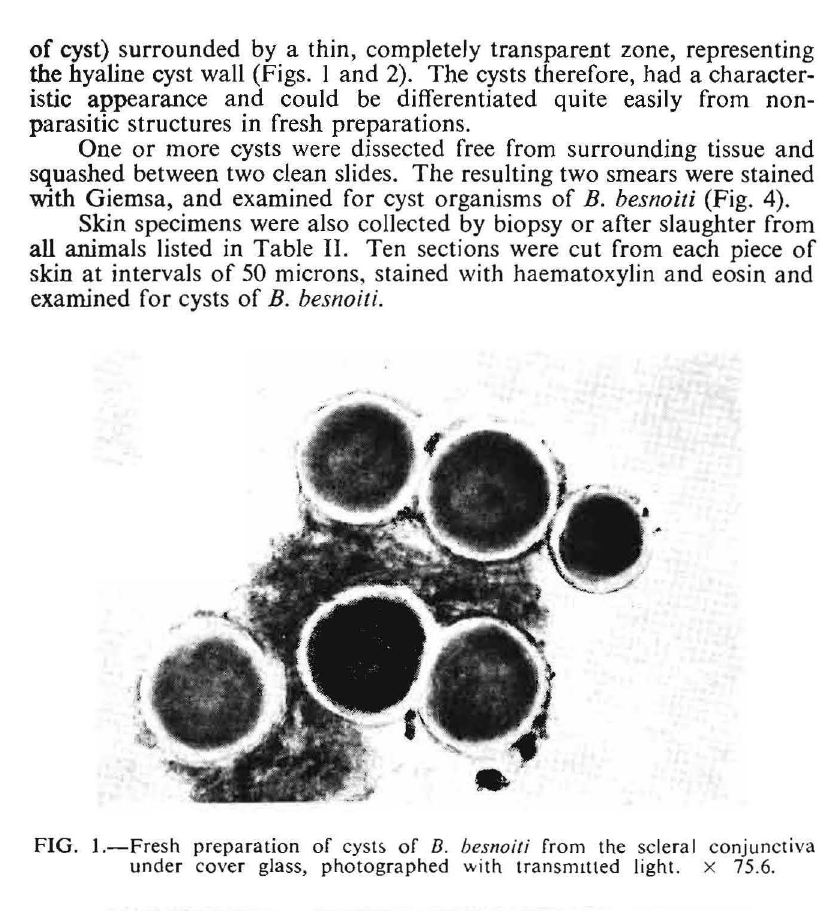
FIG. I.-Fresh preparation of cysts of B. beslIoili from the scleral conjunctiva under cover glass, photographed with transmltted light. x 75.6.